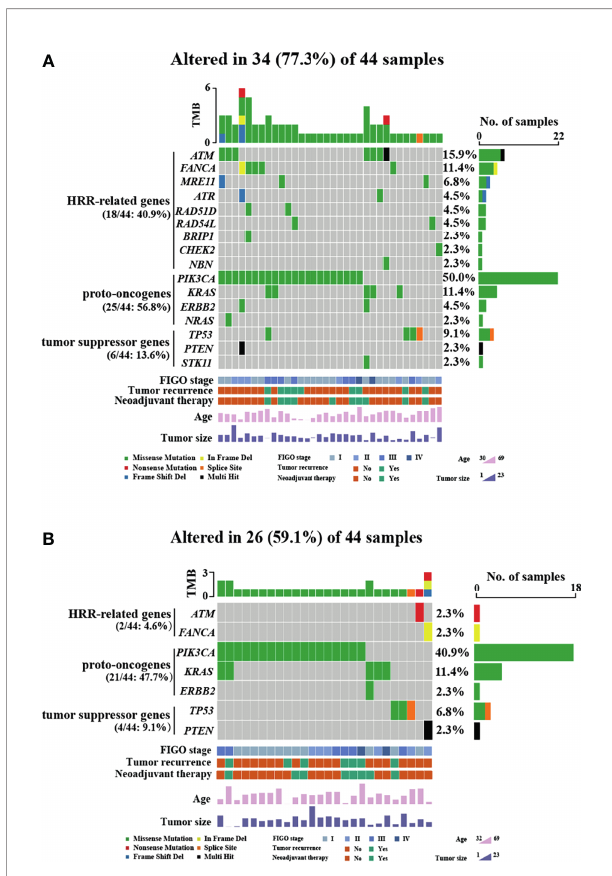
FIGURE 1 | Variants of HRR-related genes and other genes in patients with OCCC. Mutational pro fi le of both pathogenic/likely pathogenic variants and VUS (A) and pathogenic/likely pathogenic variants (B) . Each column represents one case, and rows represent an individual gene. The patients are presented in decreasing order based on the number of patients in whom a gene is mutated. The right panel indicates the frequency of gene mutations. Mutation types are indicated by different colors. Gray denotes an absence of mutations. Only variants with a VAF of >3% are shown. Clinicopathological features including age at diagnosis, FIGO stage, tumor size, neoadjuvant therapy, and tumor recurrence are annotated below the